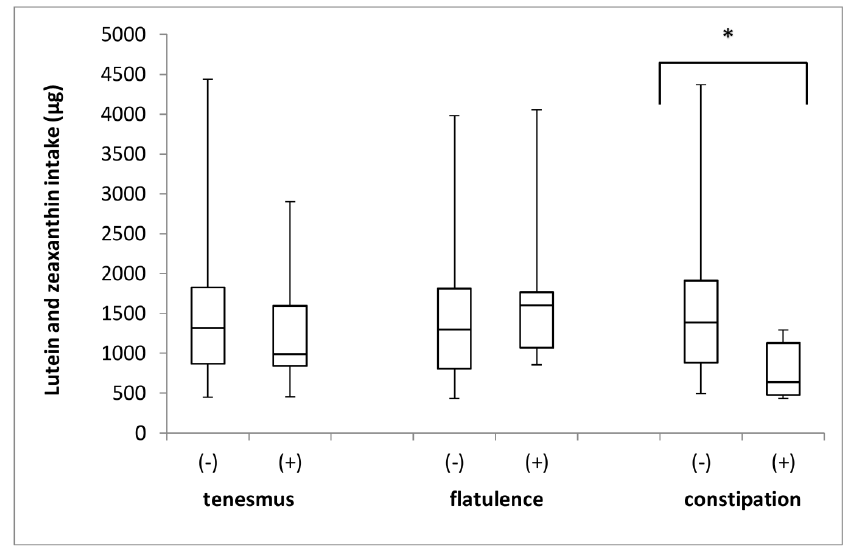
Figure 6. The box plots of lycopene intake in groups of individuals stratified by the analyzed symptoms of tenesmus, flatulence and constipation. (-) symptom not declared; (+) symptom declared. The lutein and zeaxanthin intake in the groups of individuals stratified by the incidence of tenesmus, flatulence, and constipation is presented in Figure 7. No differences in the intake of lutein and zeaxanthin were identified between the groups, with respect to the incidence of tenesmus ( p = 0.760; Mann–Whitney U test) and flatulence ( p = 0.294; Mann–Whitney U test). However, significant